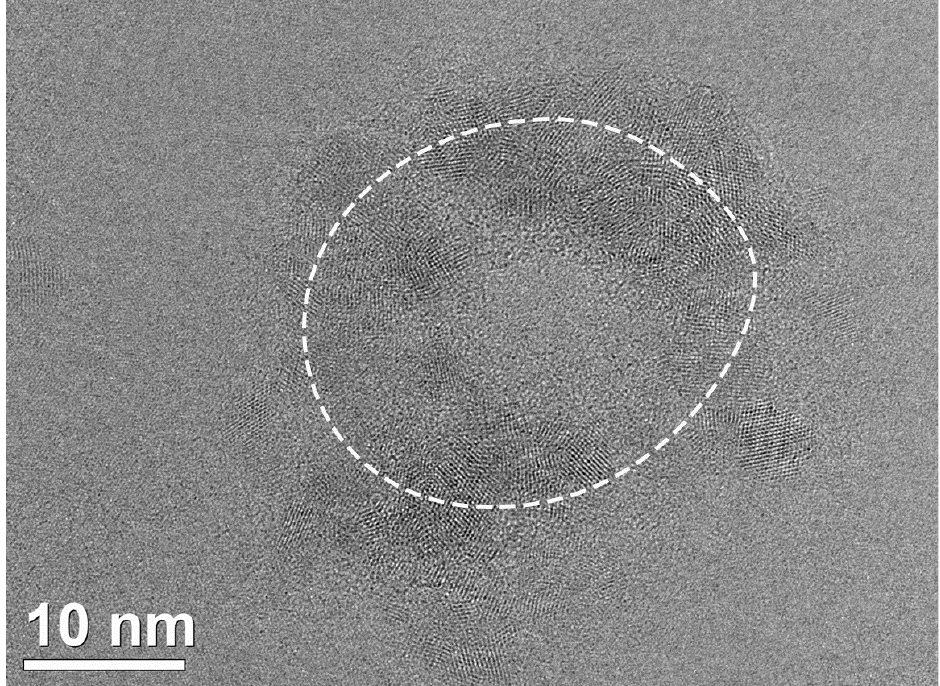
Figure 3. The cluster of nanocrystals at the periphery of the ion track at the irradiation dose of 1 × 10 11 ion/cm 2 . The ion energy is 167 MeV.